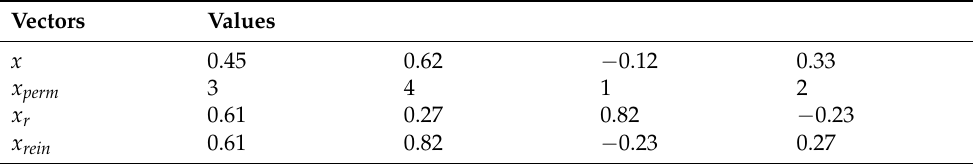
Table 3. Example of Harmony